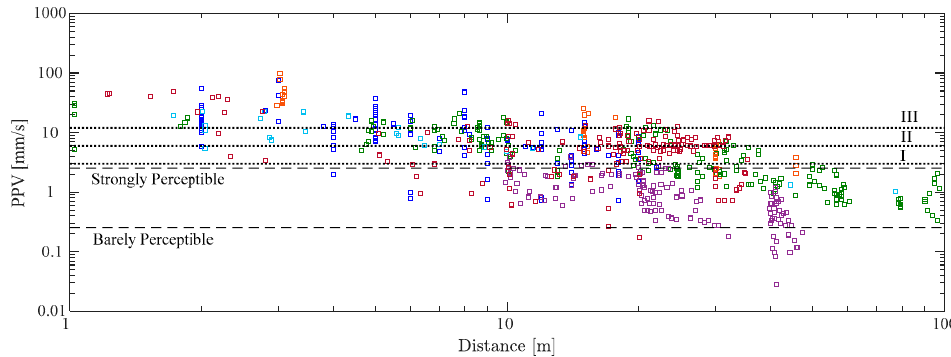
Figure 15. Maximum permitted PPV values for transient vibrations to prevent damage defined in the Portuguese Standard NP2074 (I—sensitive structures; II—current structures; III—reinforced structures).